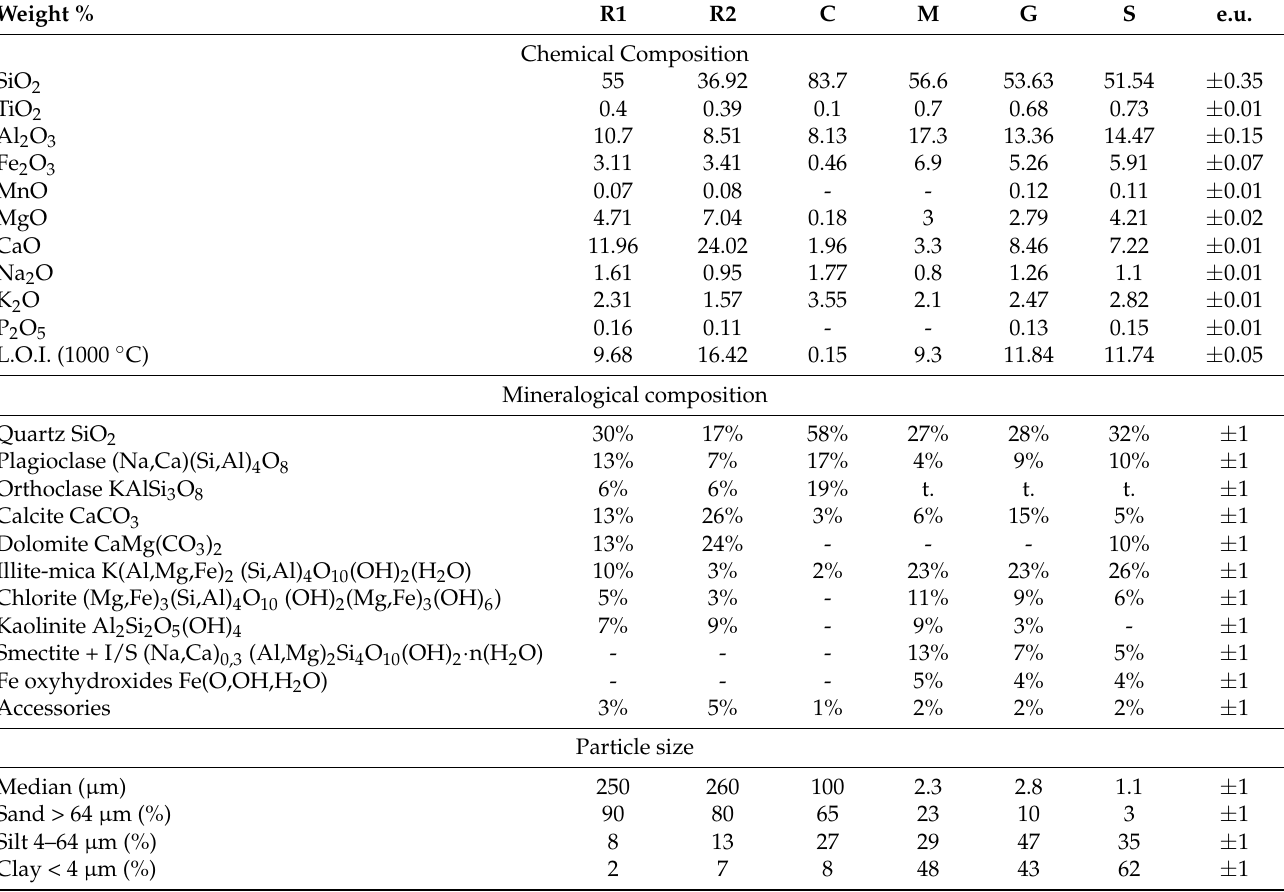
Table 1. Chemical and mineralogical composition, and particle size distribution of the CDR (R1–R2), the sand (C) and the three clays